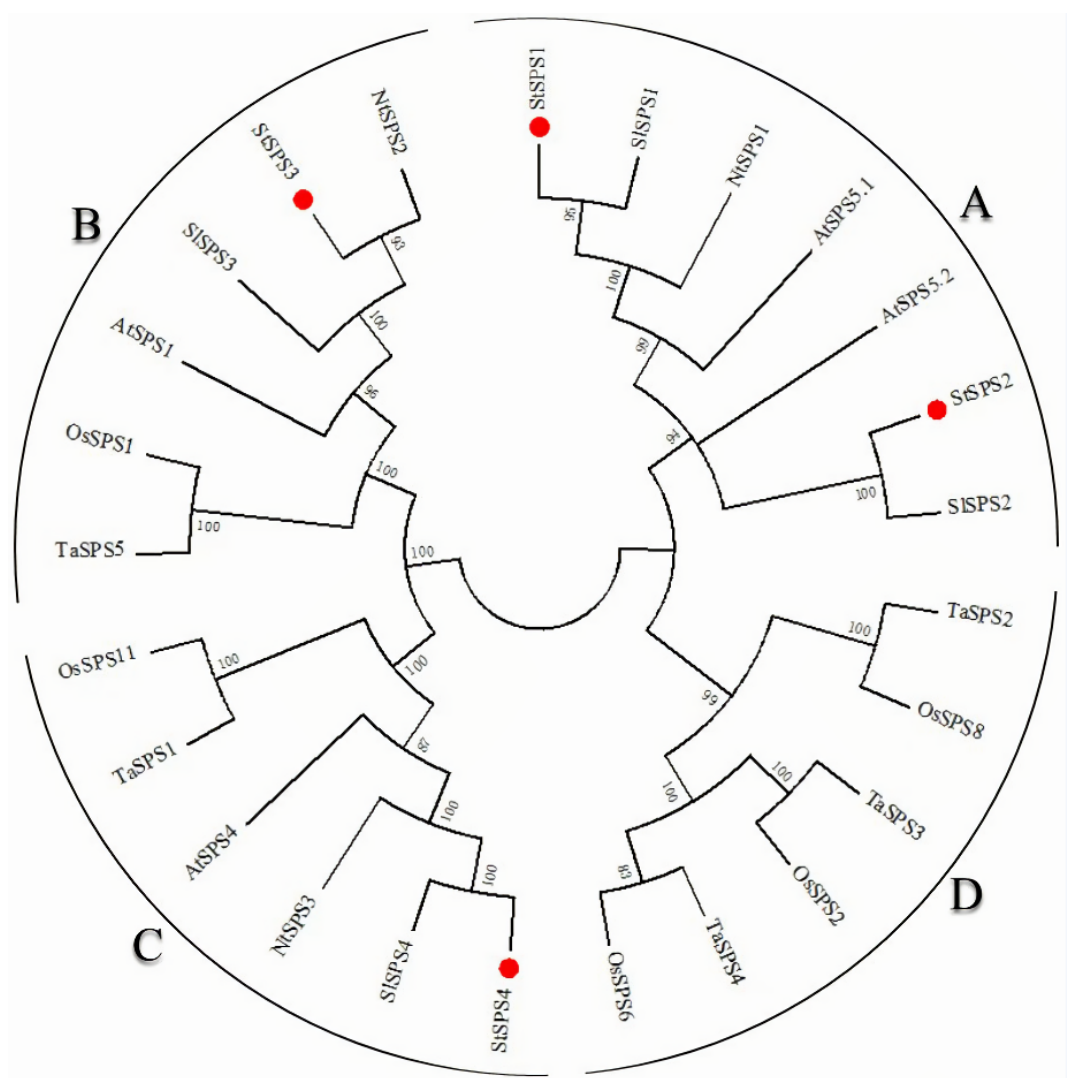
Figure 2. Phylogenetic analysis of SPS family members in Solanum tuberosum , Arabidopsis thaliana , Solanum lycopersicum , Nicotiana tabacum , Oryza sativa, and Triticum aestivum . A/B/C/D represents the four subfamilies. Specific sequence information is shown in File S2.